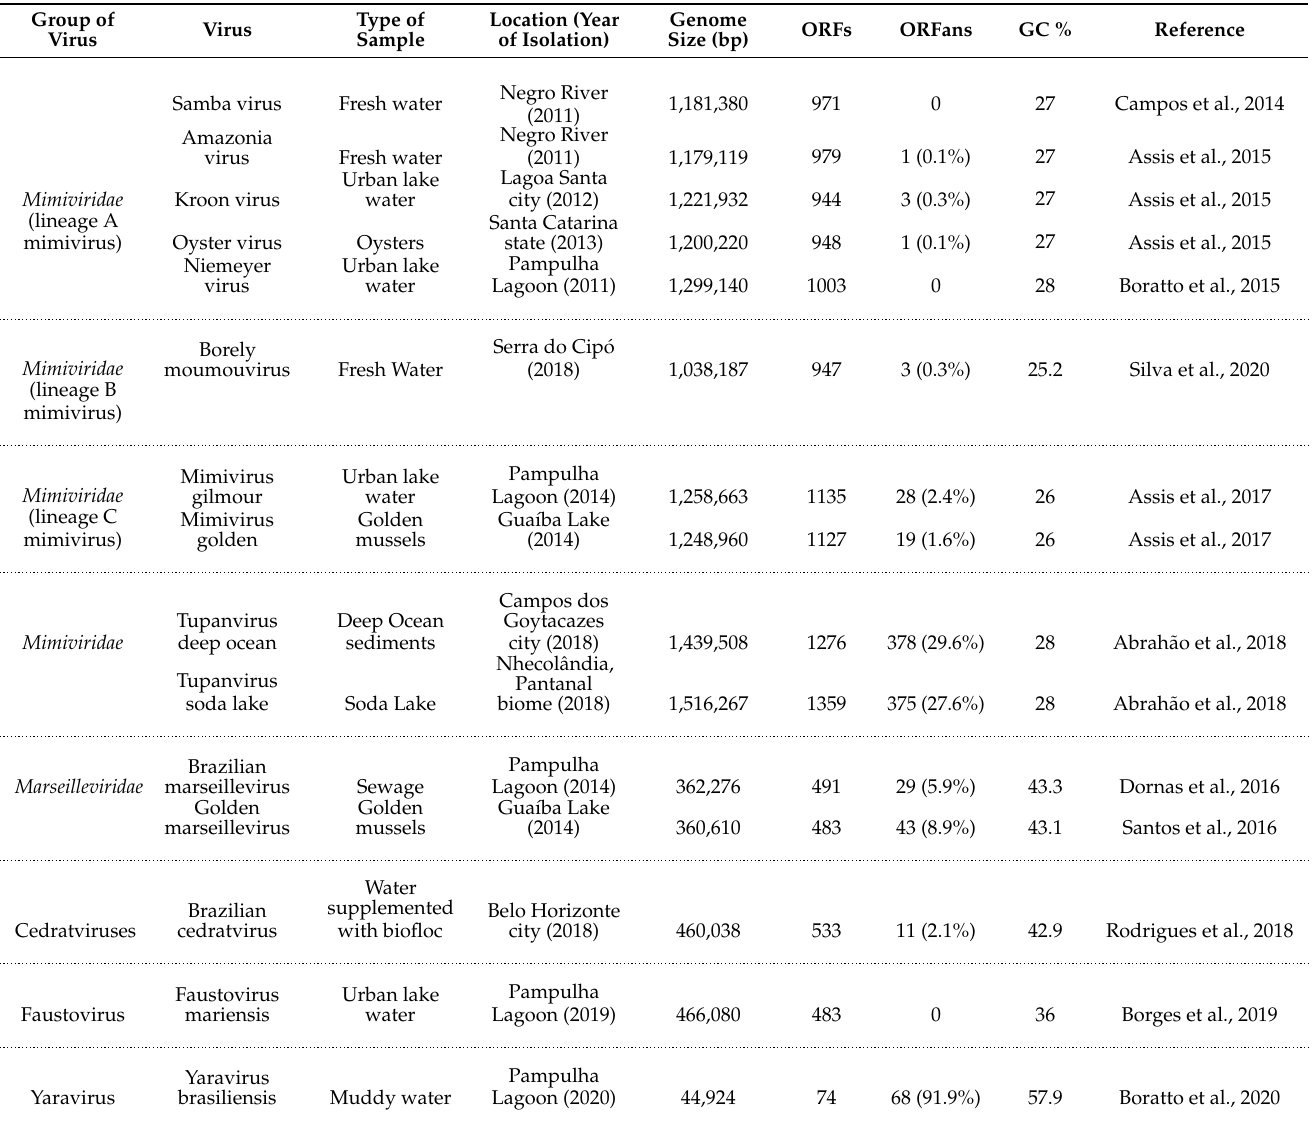
Table 1. General features of Brazilian giant viruses with complete